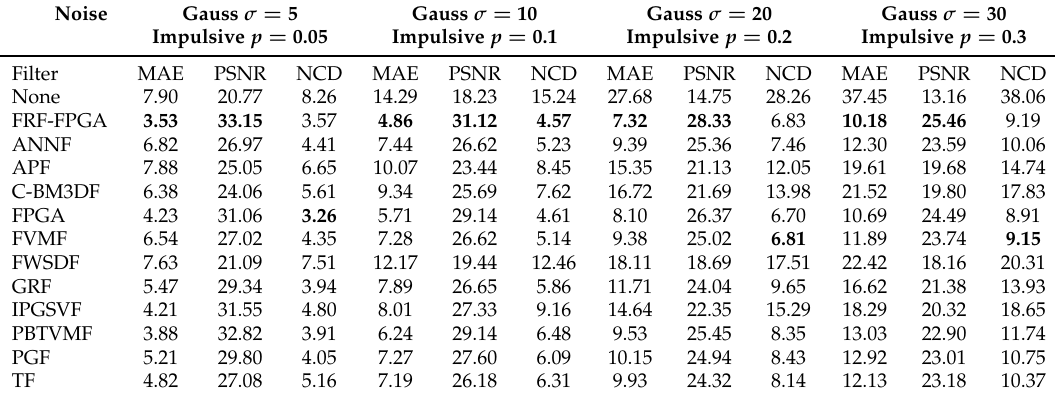
Table 1. Comparative study with state-of-the-art techniques. Lena test image corrupted with various intensities of mixed noise. Bold values express the best restoration quality.